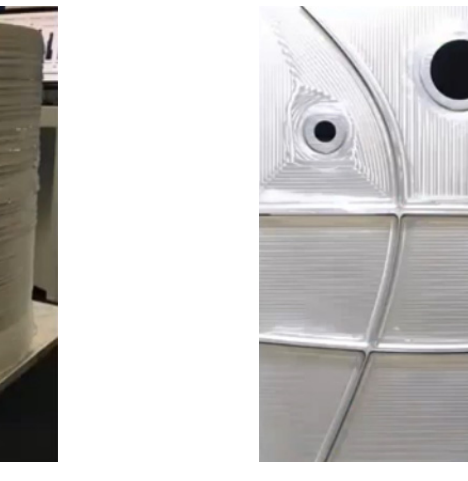
Figure 16. The fully-dense additive components with AFSD [62].